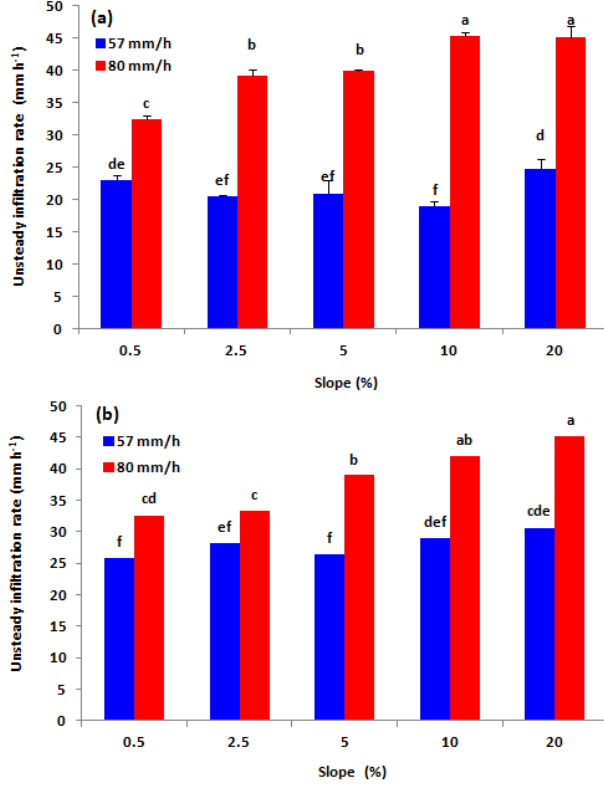
Figure 6. Time changes of infiltration rate in soil D max 4.75mm for different slope gradients and rain intensities of (a) 57 and (b) 80mmh − 1 .